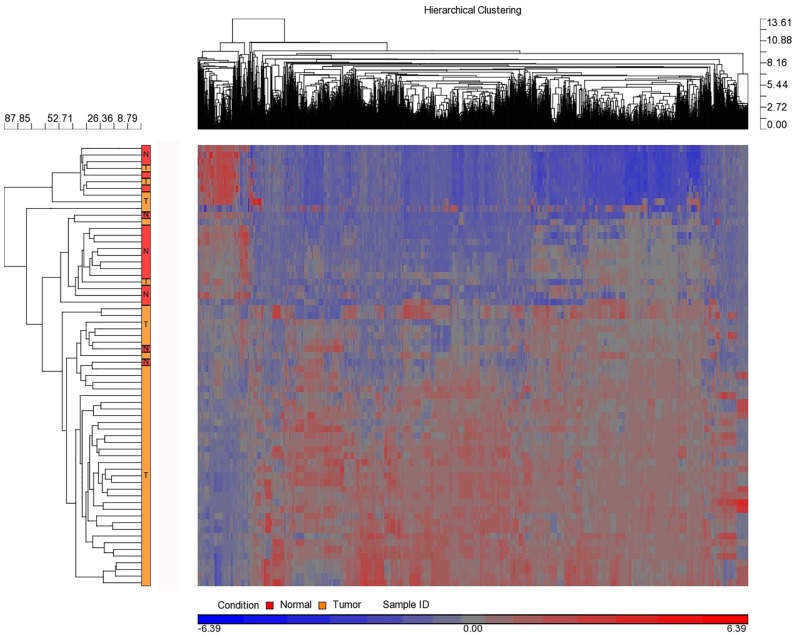
Hierarchal clustering of healthy versus tumor breast cancer tissue samples.Over 100 detected miRNAs that were differentially expressed. Heat map colors represent miRNA expression as indicated in the color key where tumor samples are from the all patients whereas normal tissue from the full follow-up patients.